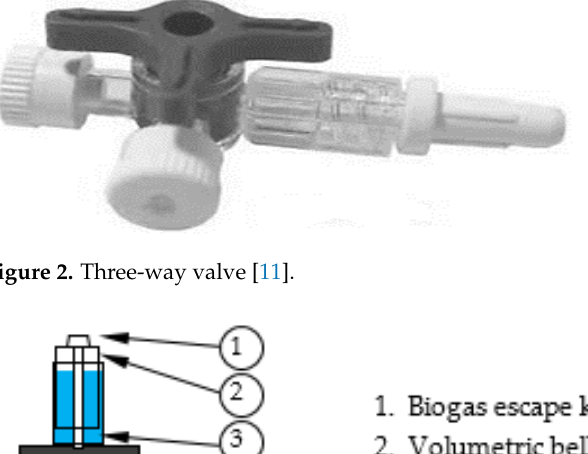
Table 1. Amounts imposed on the substrate for tests one to six.